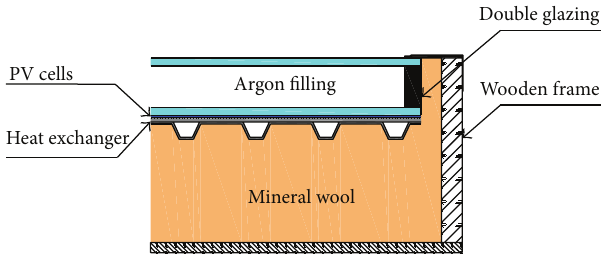
Figure 1: Layout of the investigated glazed PVT collectors.